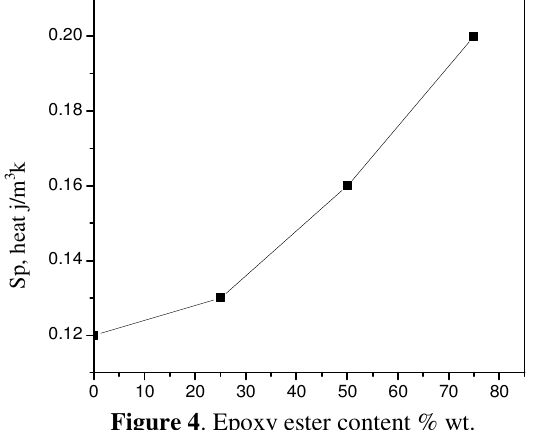
Figure 4 . Epoxy ester content % wt.